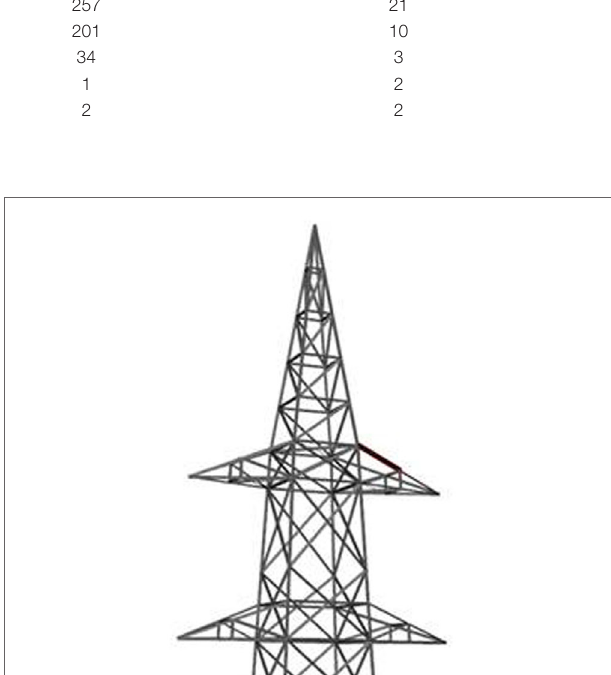
TaBle 6 | intuitive method of placing sensors by maximum forces.